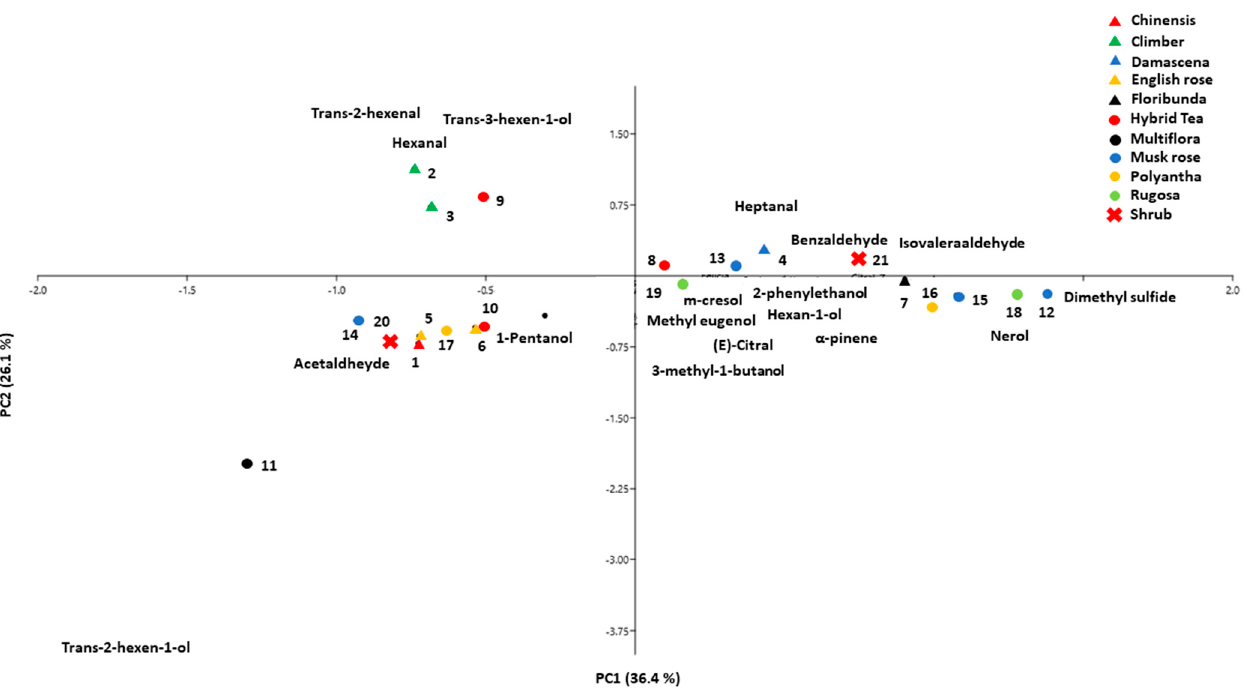
Figure 4. Principal component analysis (PCA)-biplot of the studied garden rose genotypes and volatile compounds emitted by petals. Numbers indicated the garden rose genotypes as listed in Table 1.